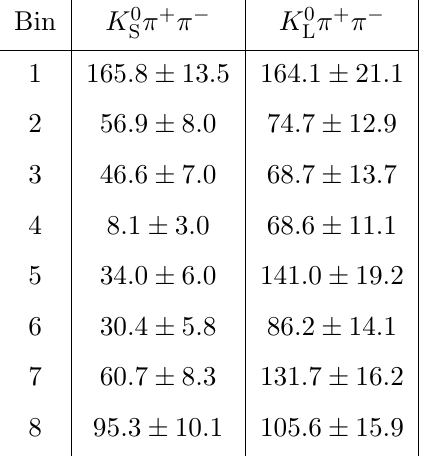
Table 3 . Background subtracted e(cid:14)ciency corrected yields of D ! K 0